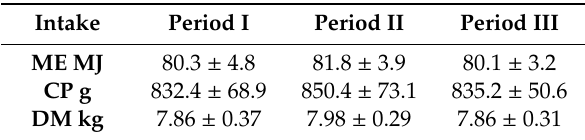
Table 3. Average daily ME, CP and DM intakes ( ± s.d.) for each